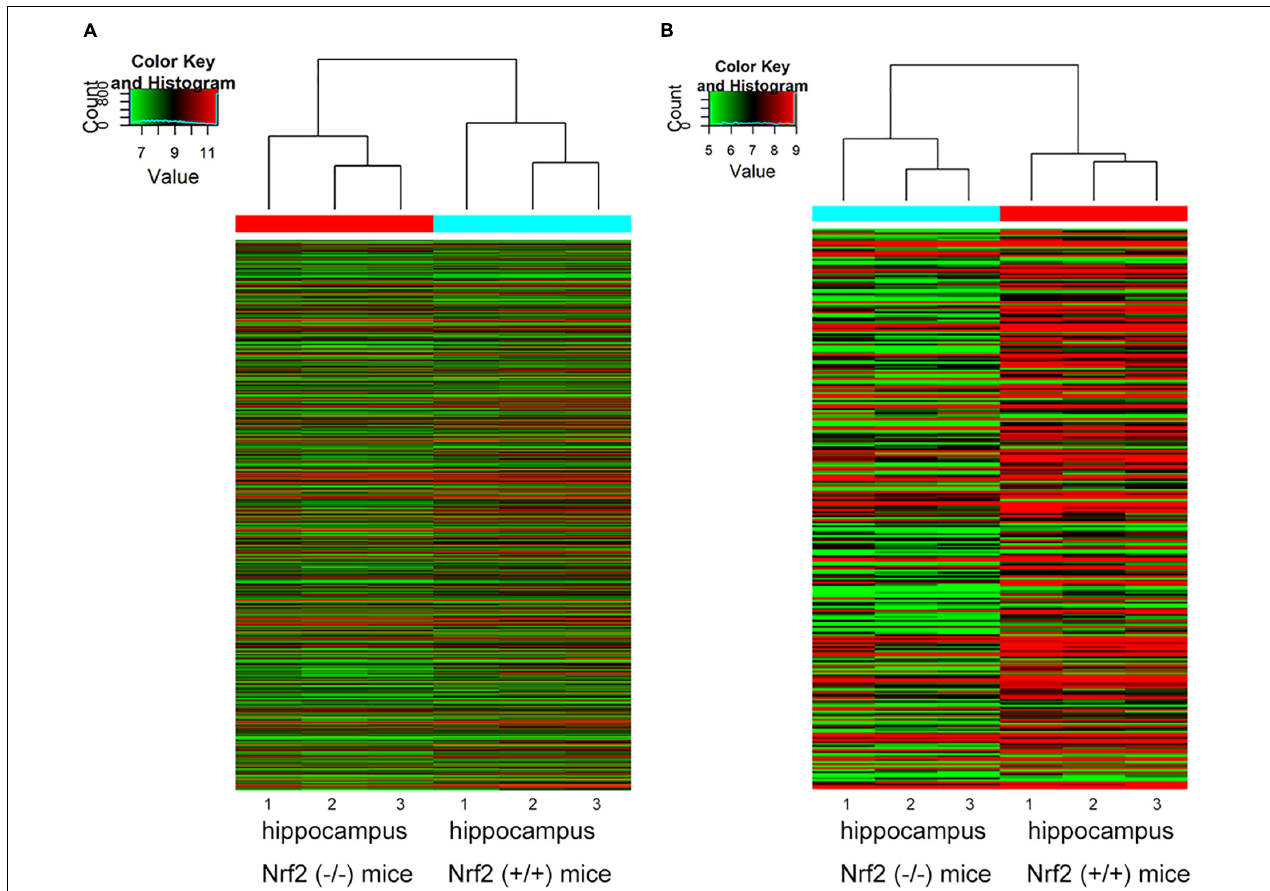
FIGURE 3 | Hierarchical clustering analysis based on the expression profile of the DEcircRNAs (A) and DElncRNAs (B) in Nrf2 (–/–) the hippocampus. n = 3.